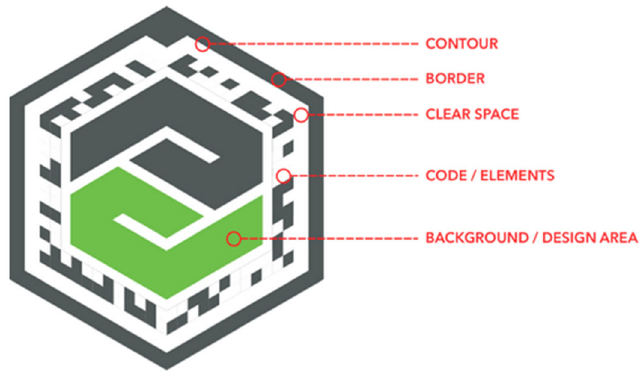
Figure 9. Design division of the Marker [30].